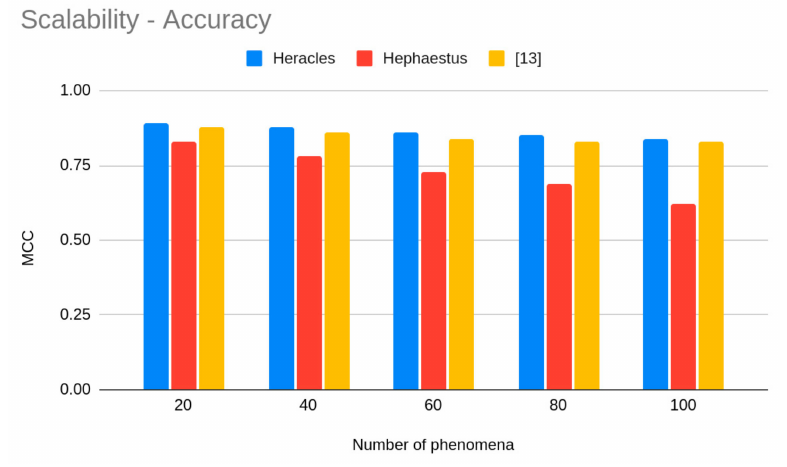
Figure 6. Accuracy scalability.